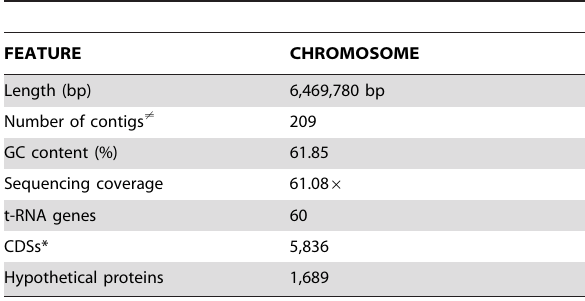
Table 1. Features associated with genome of P. putida CSV86 according to NCBI